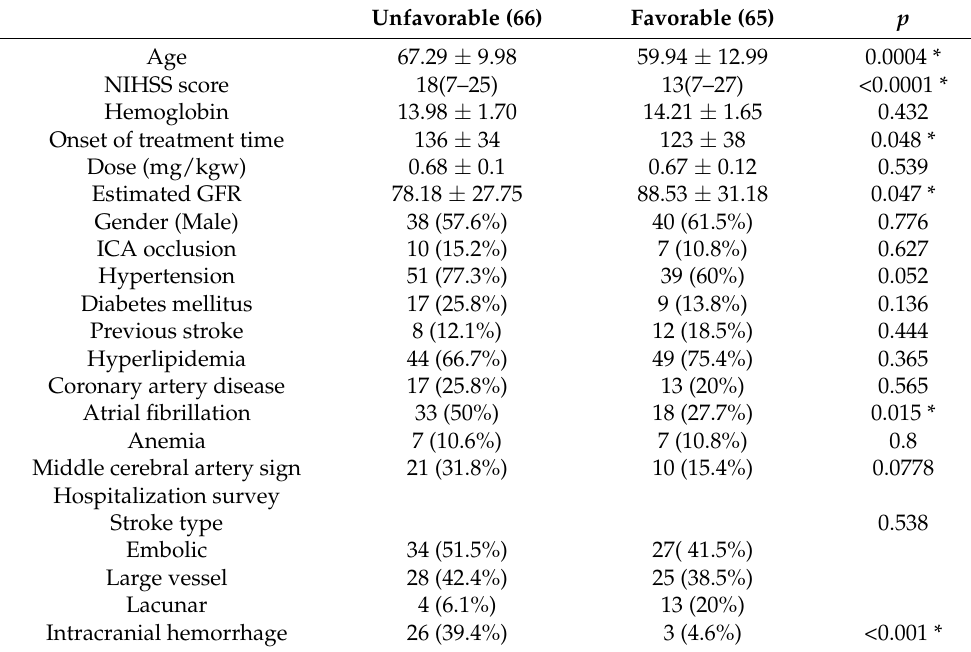
Table 1. Different characteristics between the two groups in the training